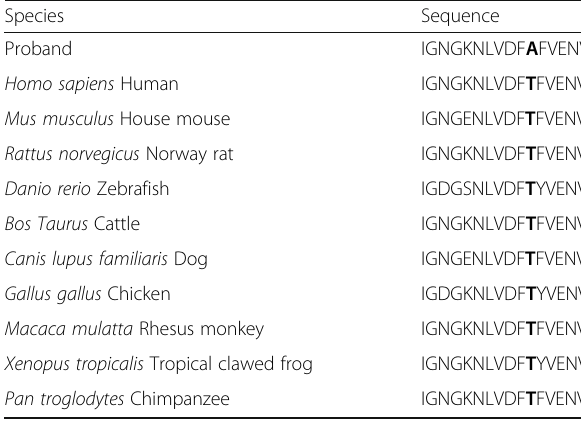
Table 3 Conservation of protein domain across species corresponding to